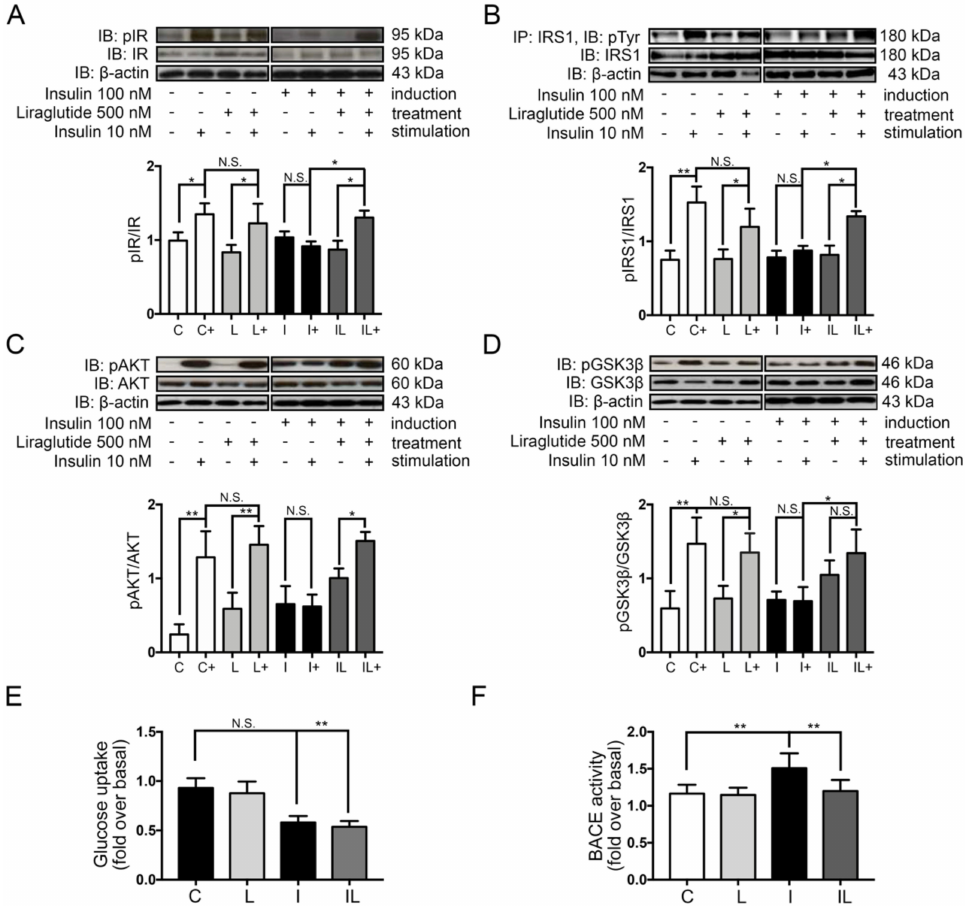
Figure 4. E ff ects of liraglutide on insulin signaling, glucose uptake, and BACE-1 activity. Western blots were performed for pIR(Tyr1162 / 1163), IR, pAKT(Ser473), AKT, pGSK-3 β (Ser9), and GSK-3 β . Thebandsandbargraphsrepresentdensitometricvaluesofeachlaneafternormalizingwithtotalprotein expression; pIR(Tyr1162 / 1163) / IR β ( A ), pAKT(Ser473) / AKT ( C ), pGSK-3 β (Ser9) / GSK-3 β ( D ). The bands and bar graphs of immunoprecipitated IRS-1 followed by pTyr Western blotting of pIRS-1(Tyr) / IRS-1 representing densitometric values of each lane are shown in ( B ). The e ff ect of liraglutide treatment on glucose uptake is shown in ( E ) . The BACE-1 activity is shown in ( F ). Values are mean ± SEM, * p < 0.05 ** p < 0.01 compared with neuronal insulin-resistant cells. All experiments shown were from n =